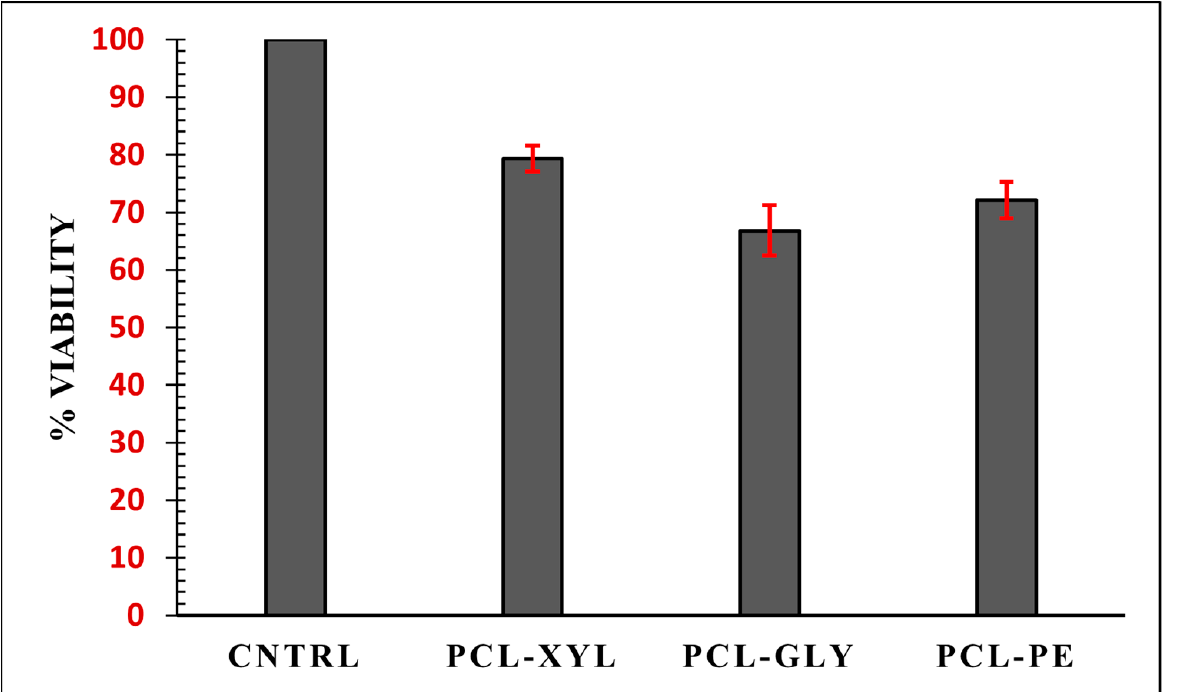
Figure 7. Cytotoxic effect on hAMSCs after incubation with the synthesized PCL copolymers.